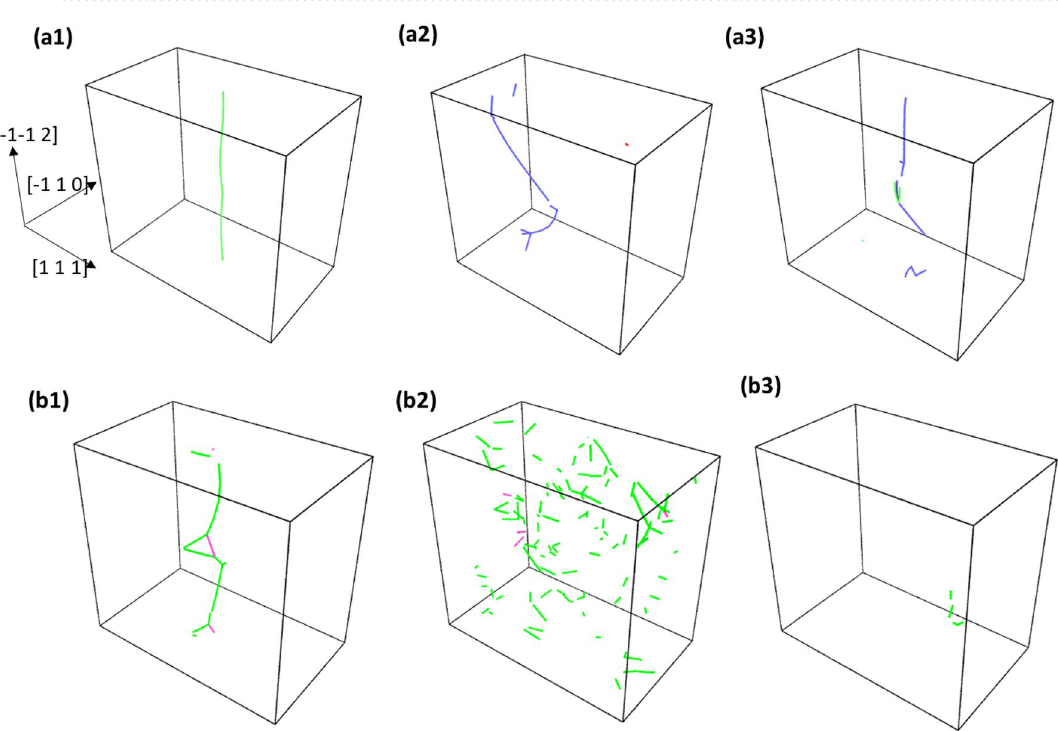
Figure 7. DXA dislocation line core analysis for BCC alloy structure: ( a1 – a3 ) are for the 5 MC swap and ( b1 – b3 ) are for the 15 MC swap structure under the application of 1500 MPa shear stress. Structures are taken approximately 50 ps apart in simulation time. Figure was made using OVITO 2.9.0. URL: https ://www.ovito